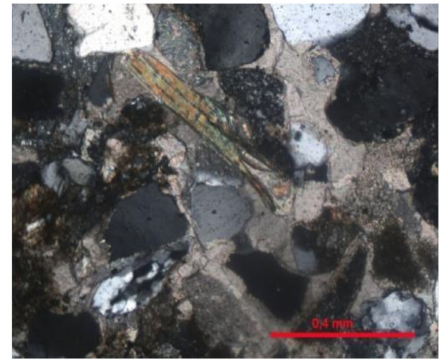
Figure 2. Thin section observations.